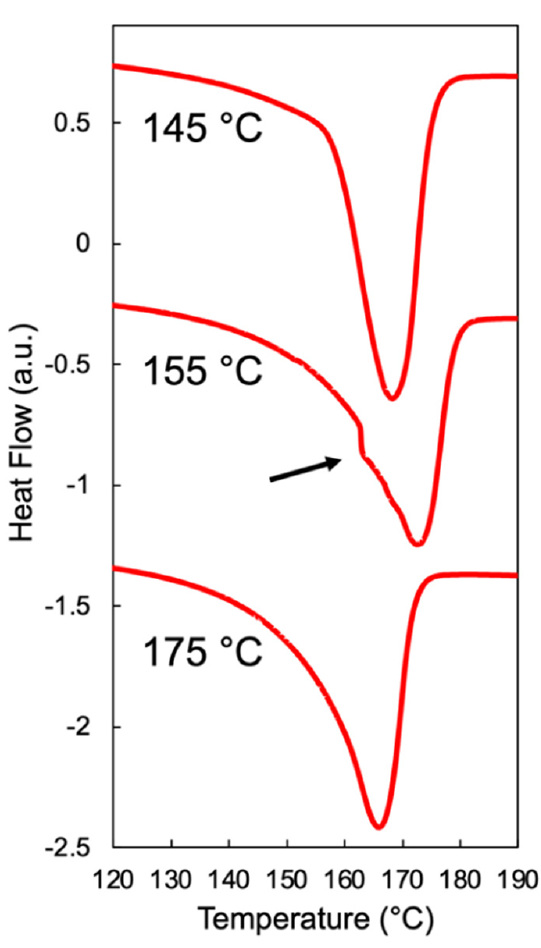
Figure 8. Heating endotherm of Resin B foamed using Method 1 as measured by DSC. Shoulder at 155 °C reflects the presence of unmolten crystallites prior to foaming, and shift in melting peak to a higher temperature indicates heterogenous crystallization onto existing crystals.